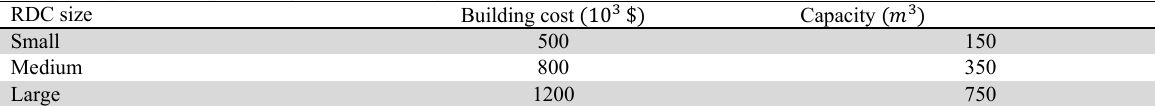
RDC setup cost depending on its storage capacity